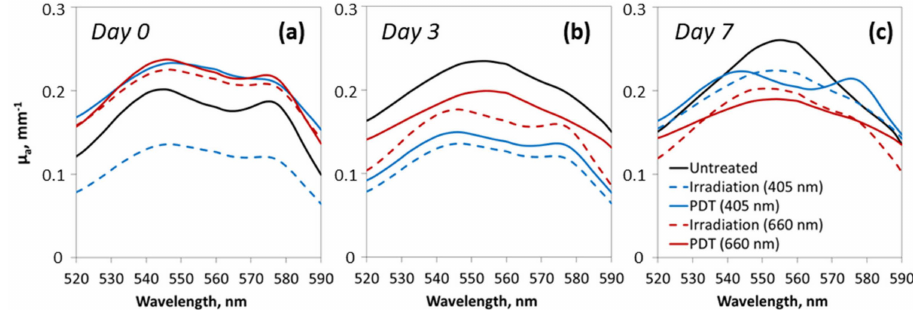
Figure 4. Typical reconstructed absorption spectra of tumor tissue before the experiment on day 0 ( a ), and on day 3 ( b ) and day 7 ( c ) after the irradiation